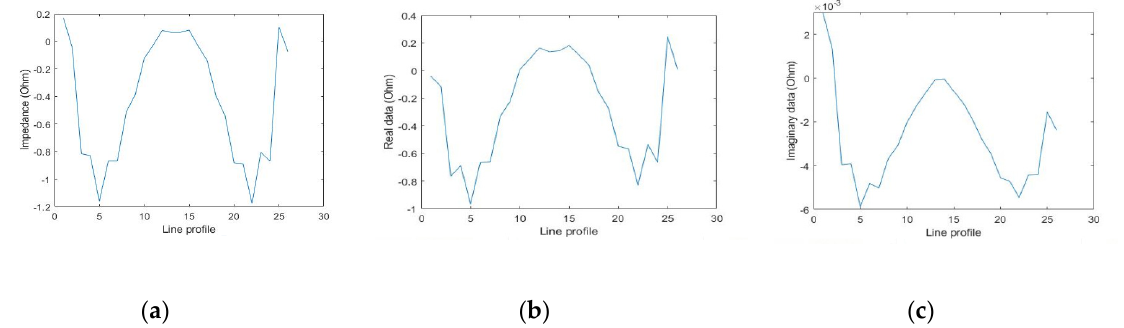
Figure 14. ( a ) Impedance image, ( b ) real image, ( c ) imaginary image. Figure 15. Line profile of ( a ) impedance image, ( b ) real image, ( c ) imaginary image.